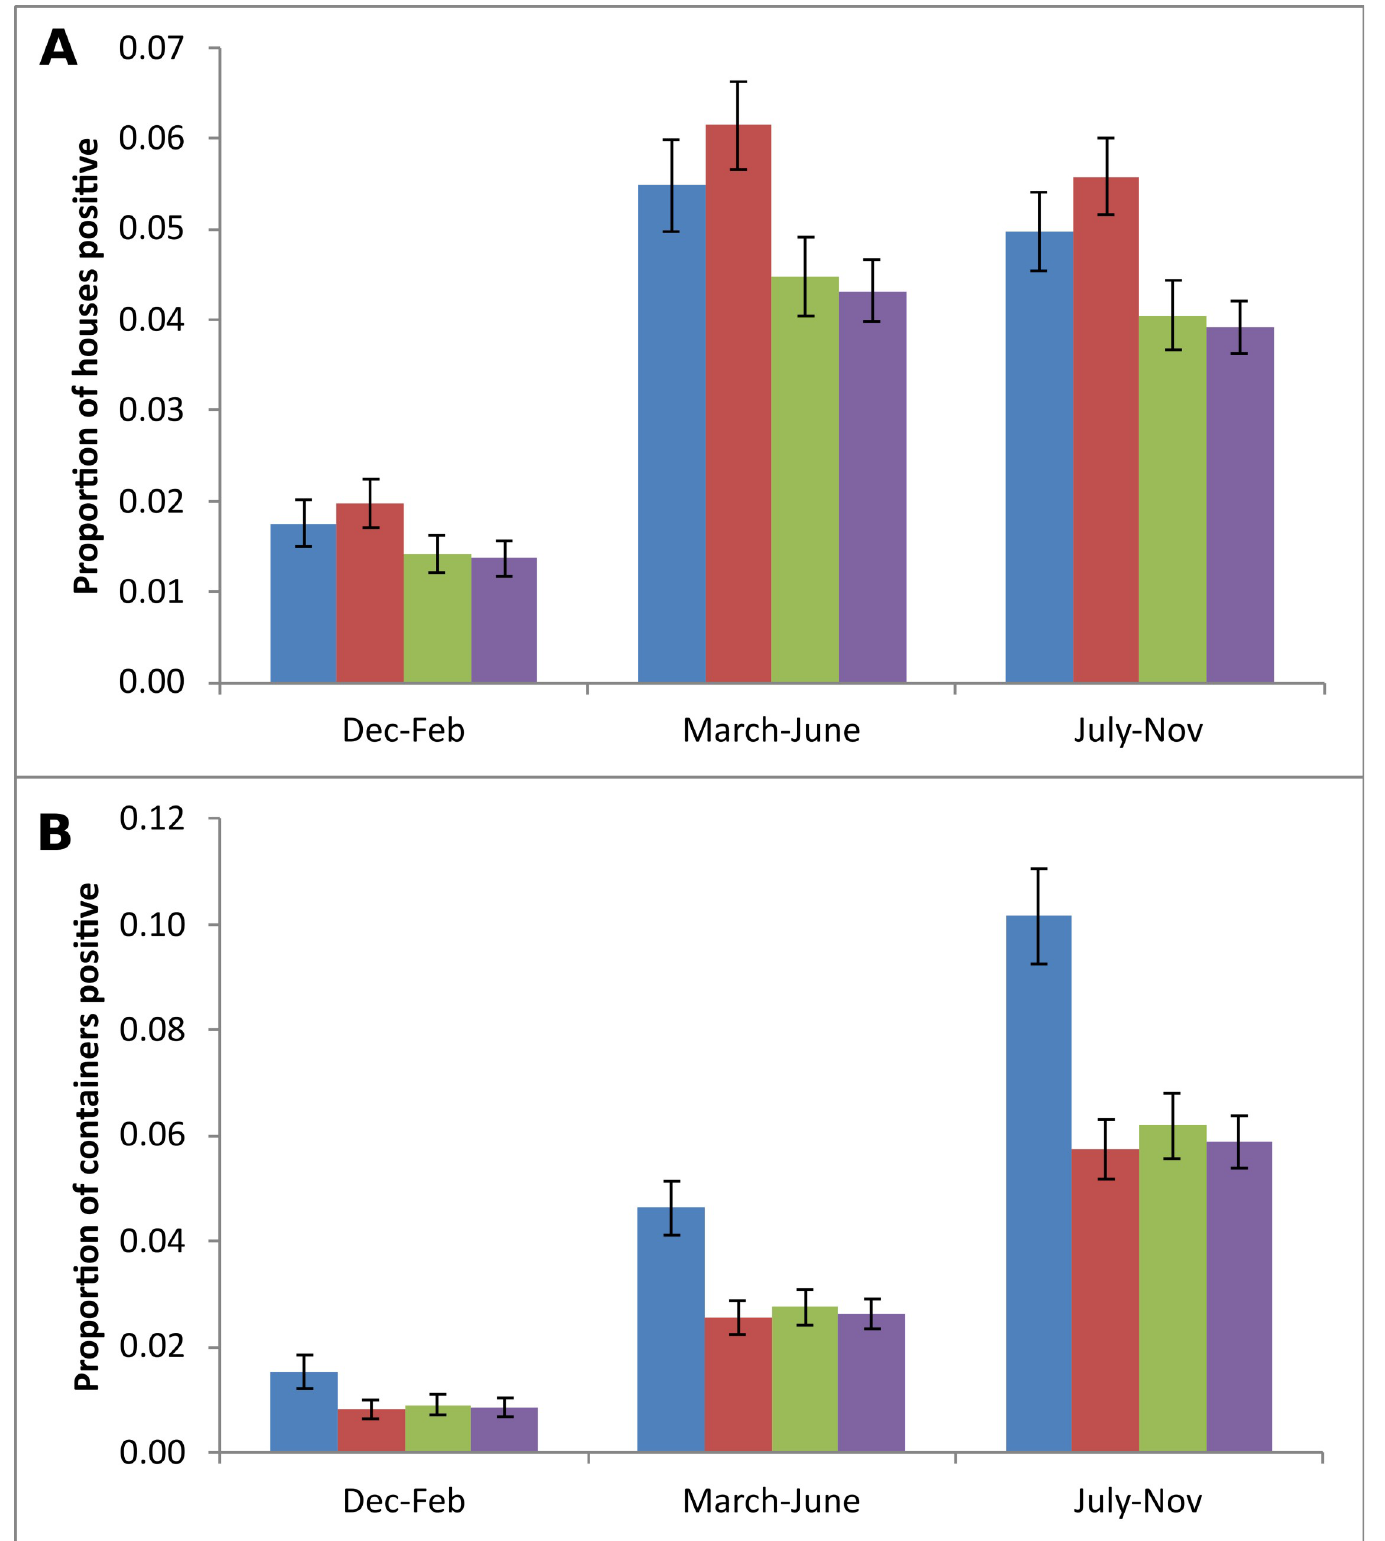
Fig 3. House Index and Container Index by season and Tap water access categories (Blue: 24–60%; Red: 61–92%; Green: 93–98%; Mauve: > 98%). Shown are Means and standard errors. https://doi.org/10.1371/journal.pntd.0009024.g003 PLOS NeglectedTropical Diseases | https://doi.org/10.1371/journal.pntd.0009024 February 11,